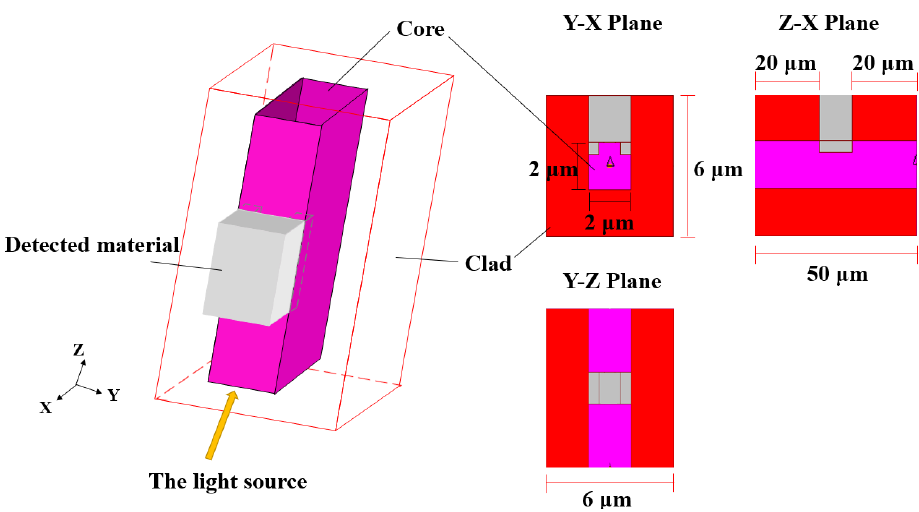
Figure 4. The structure of the embedded OW.